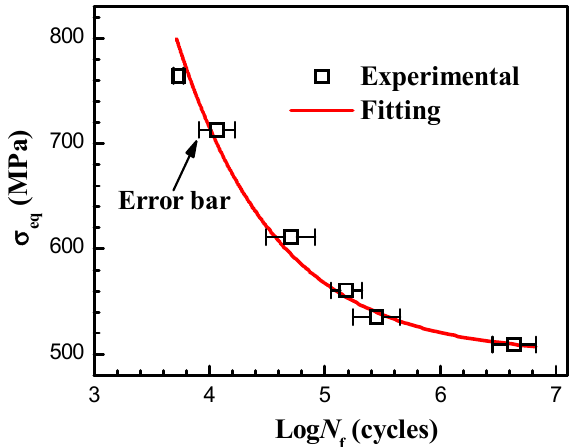
Figure 5. Testing results and fitting curve of tension–torsion fatigue lives under proportional